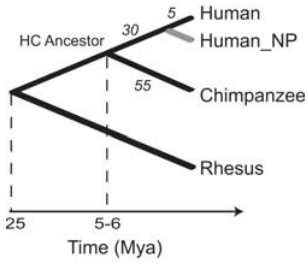
Figure 1. Phylogenetic tree of human, chimpanzee and rhesus monkey showing new numt insertions used for DSBR analysis. Recent human and chimpanzee numt insertions according to triangu- late classification are shown on each branch. The numt polymorphic variants [16] (NP, in gray) are optional in our analysis. Human and chimpanzee (HC) common ancestor is